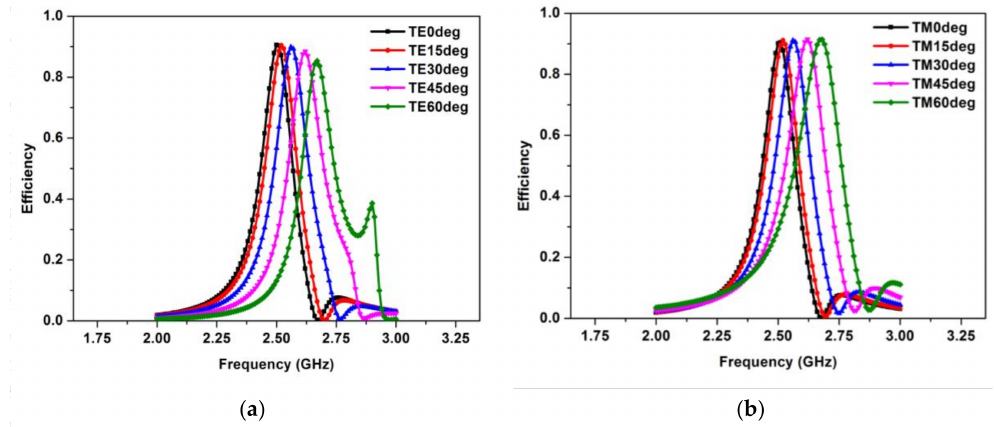
Figure 6. Power harvesting efficiency of ( a ) transverse electric (TE)-polarized oblique incidence and ( b ) transverse magnetic (TM)-polarized oblique incidence.